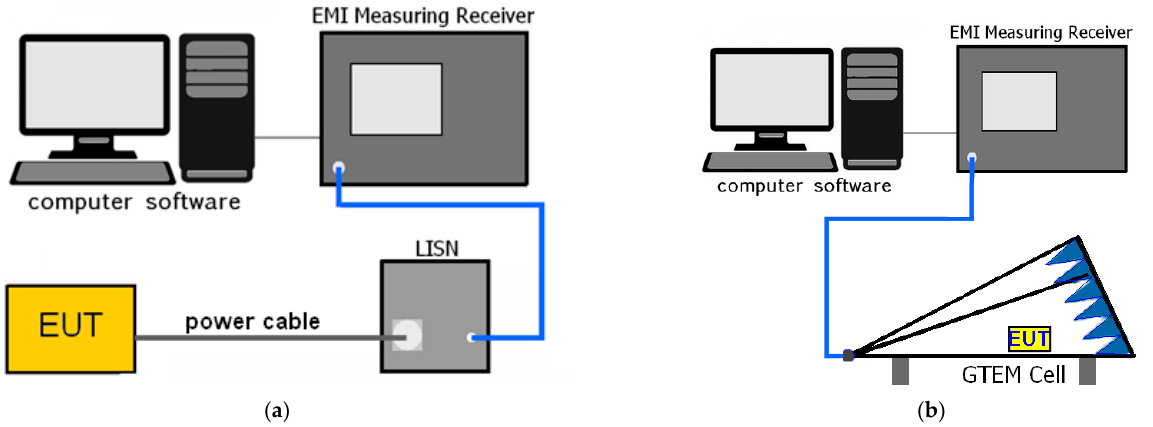
Figure 1. Measuring systems for: ( a ) conducted emission tests; ( b ) radiated emission tests.